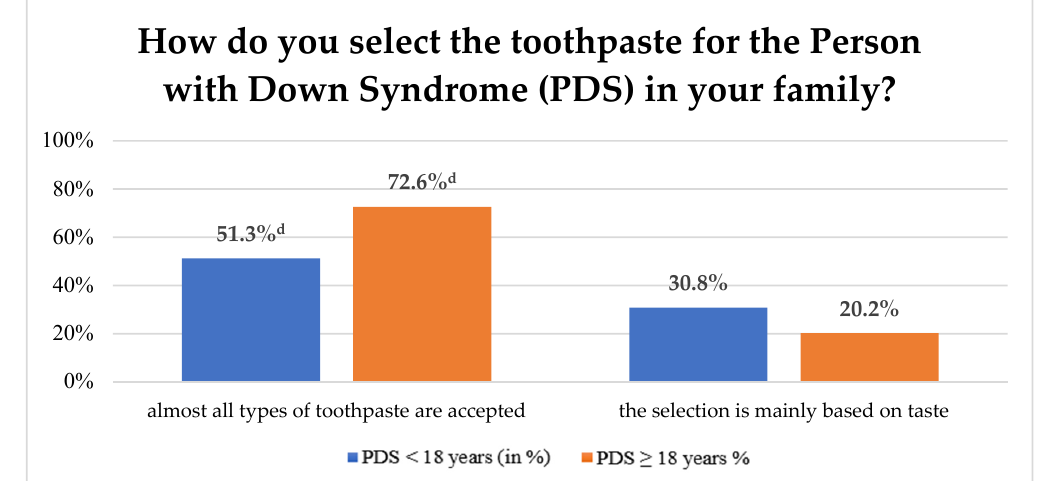
Figure 1. Percentage distribution of toothbrush types used by children and adolescents with Down Syndrome and by adults with Down Syndrome ( c — p = 0.001).